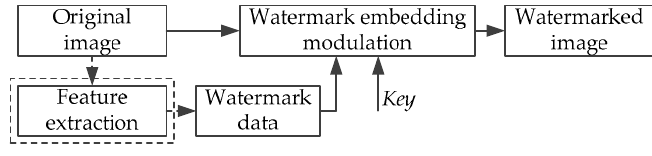
Figure 1. Watermark embedding process.